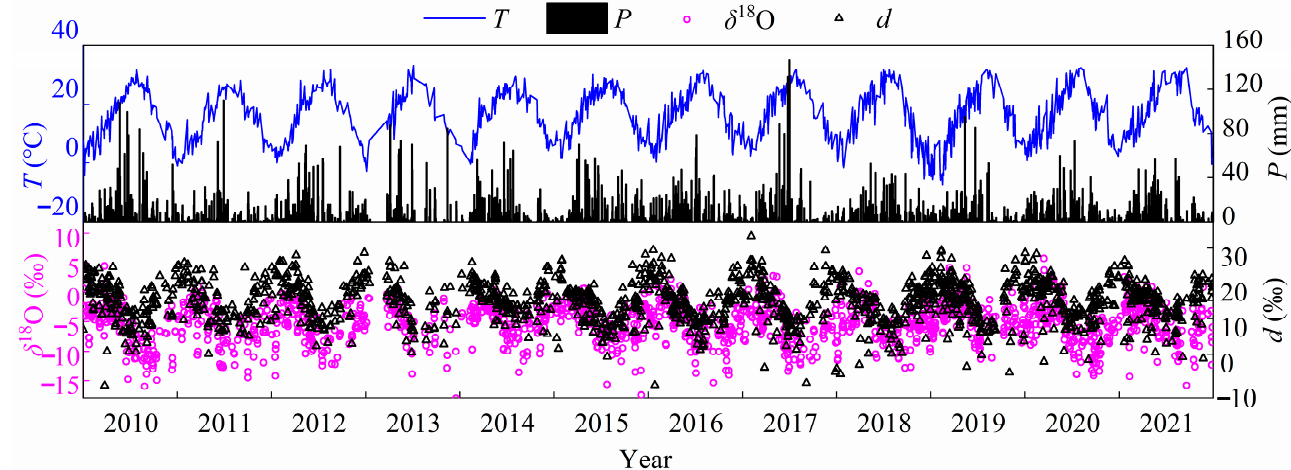
Figure 2. Temporal variation in daily temperature ( T ), precipitation ( P ), δ 18 O p and d- excess ( d ), from 1 January 2010 to 31 December 2021, at Changsha station.